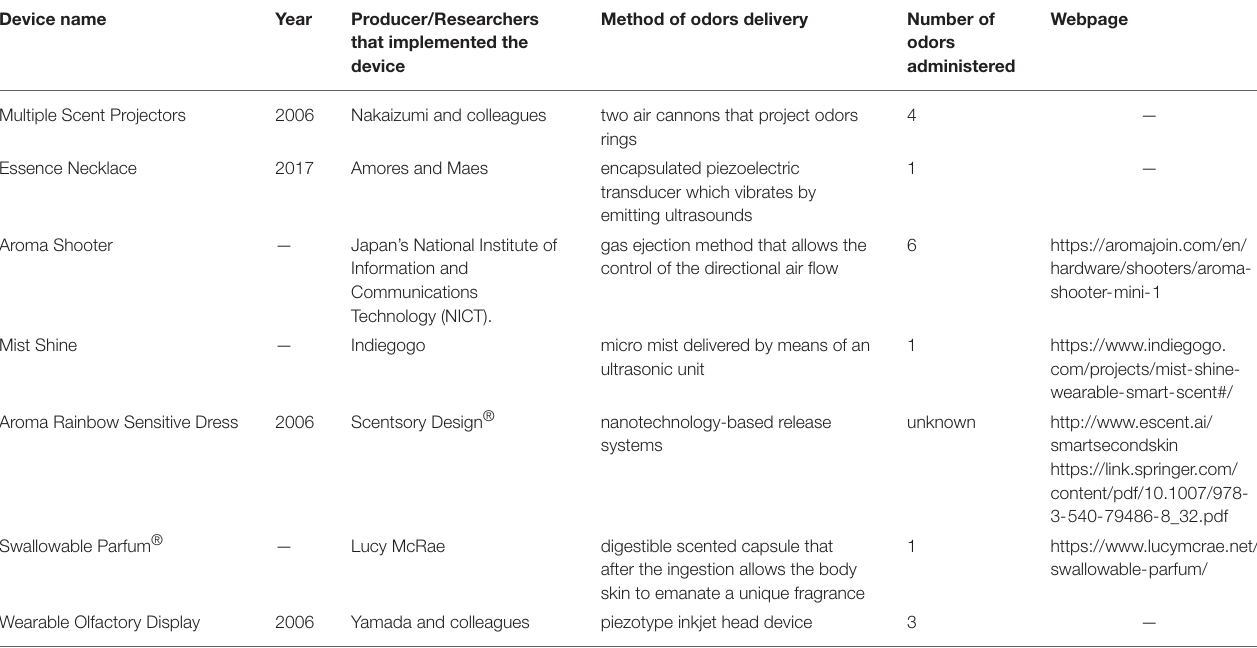
TABLE 1 | Key features of the reviewed